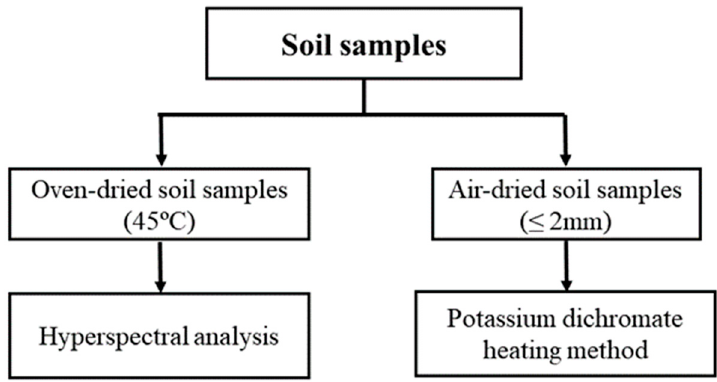
Figure 4. Workflow of sample preparation for the chemical and spectral analysis.